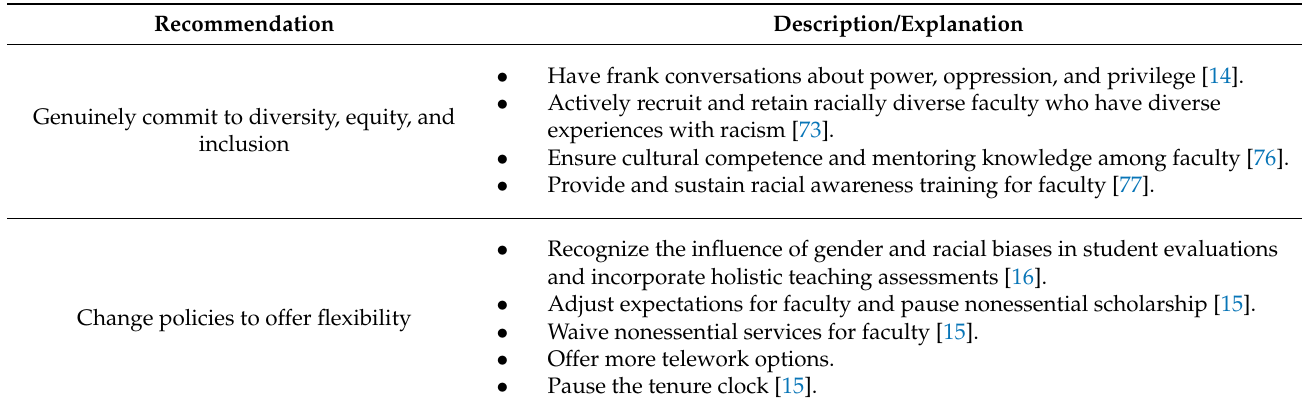
Table 1. Recommendations for institutions to support and protect Black women faculty and adminis-